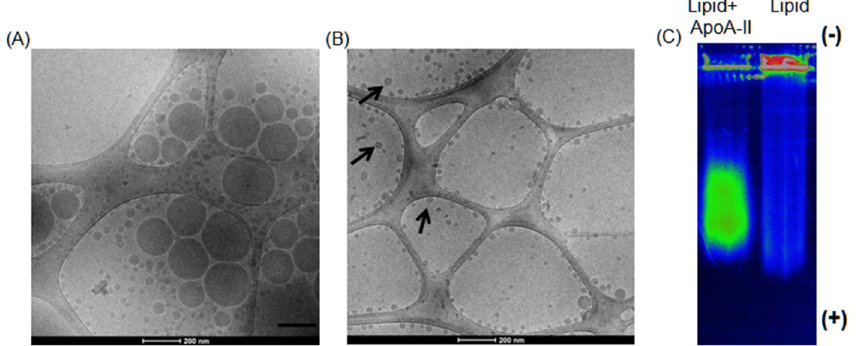
Fig 1. ApoA-II reduces the size of lipid. Cryo-TEM micrograph picture of the SMOFlipid emulsion without ApoA-II (A) and after addition of ApoA-II (B). Note the bi-layer structure of the lipid surface of the nanoparticle like structures in presence of ApoA-II (black arrows). (C) Spectral flourescence color photograph of a 0.5% agarose gel run for 45 min at 90 V in 1 × TBE buffer. SMOFlipid labeled with DiD did not migrate through the well but reconstituted labeled SMOFlipid with ApoA-II migrated as a